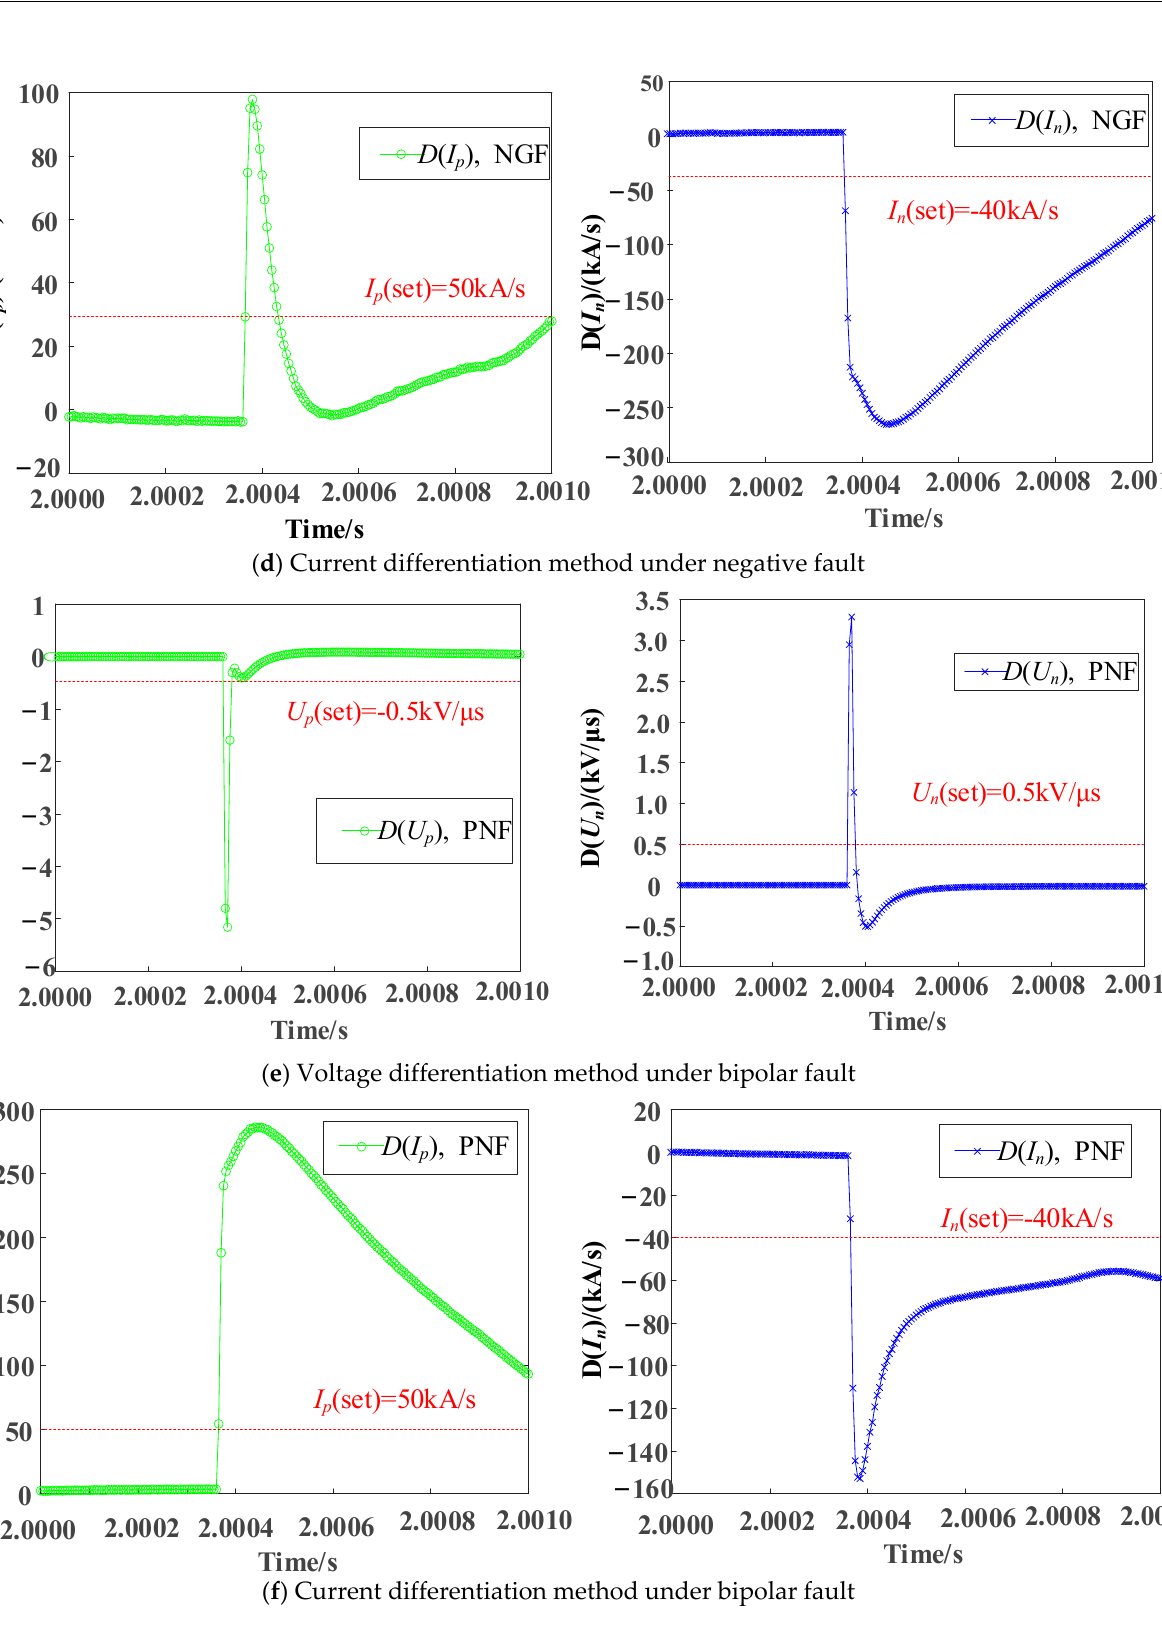
( f ) Current differentiation method under bipolar fault Figure 15. The differential variation characteristics of voltage and current on the line. In the DC grid shown in Figure 8, the faults on the DC lines L 2 , L 3 and L 4 are all external faults for the protection of R1, and the faults on L 2 and L 3 are more serious. When a metallic bipolar grounding short-circuit fault occurs outside the protection zone, it is